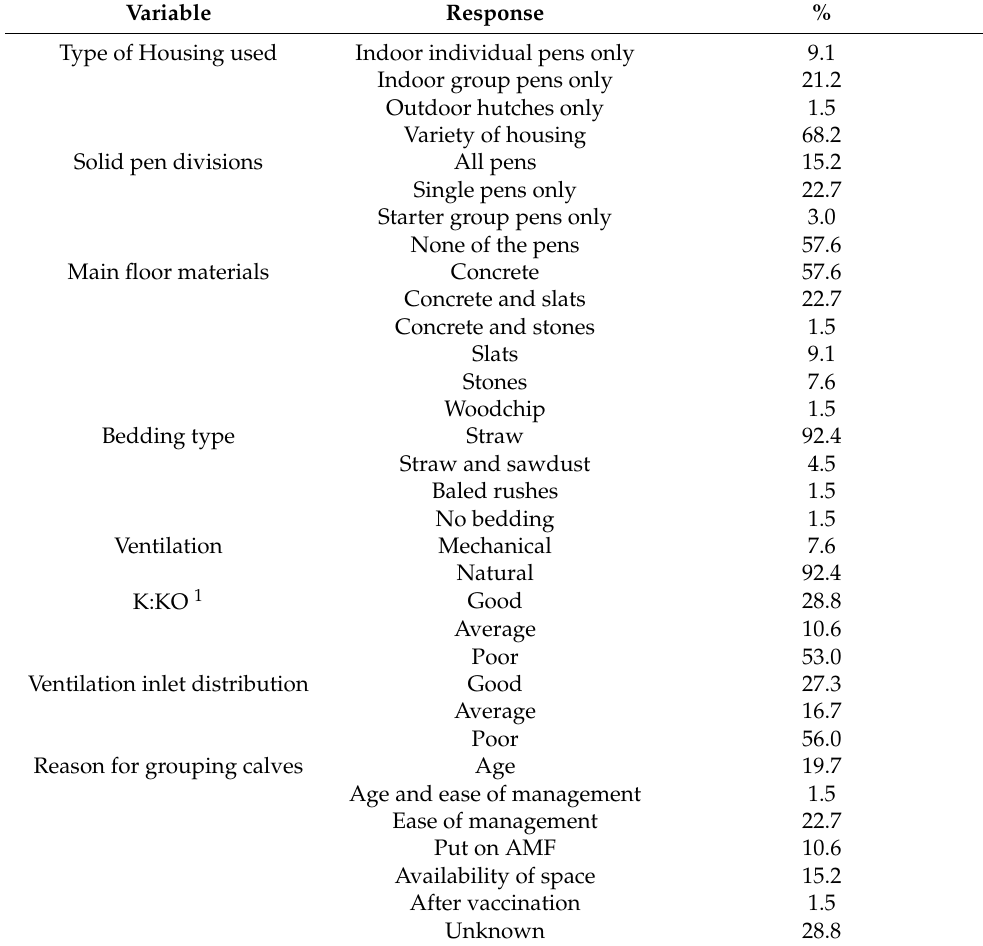
Table 5. Physical housing